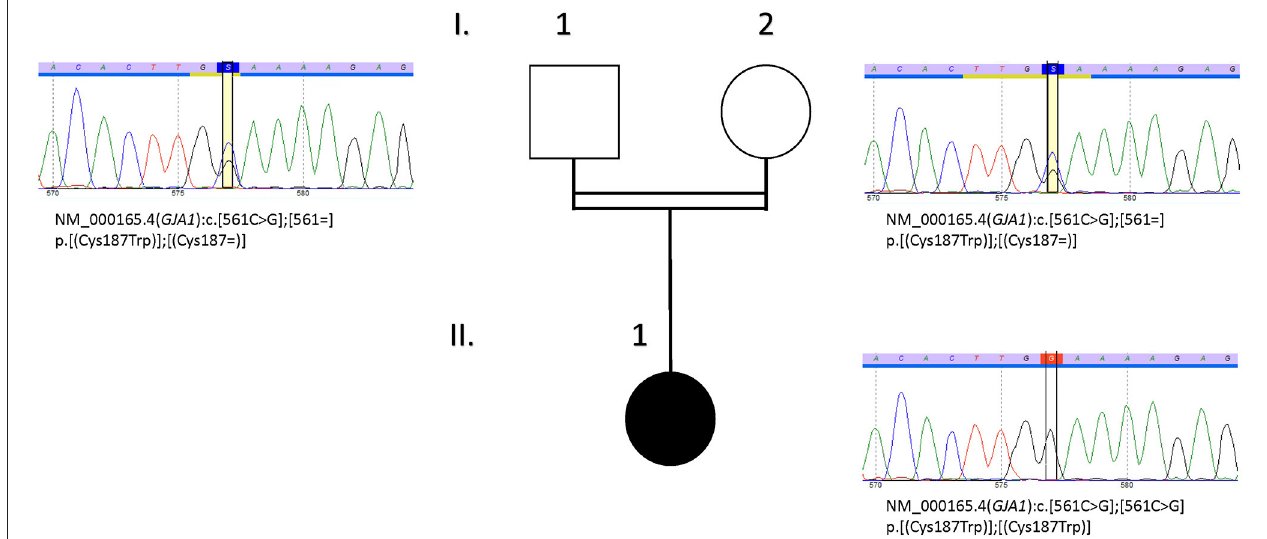
FIGURE 2 | Pedigree and DNA sequencing chromatograms of the family. Sanger sequencing was done to confirm familial segregation of the variant NM_000165.4 ( GJA1 ):c.[561C > G] identified by exome sequencing. Parents (I.1 and I.2) were heterozygous and the index case (II.1) was homozygous for this